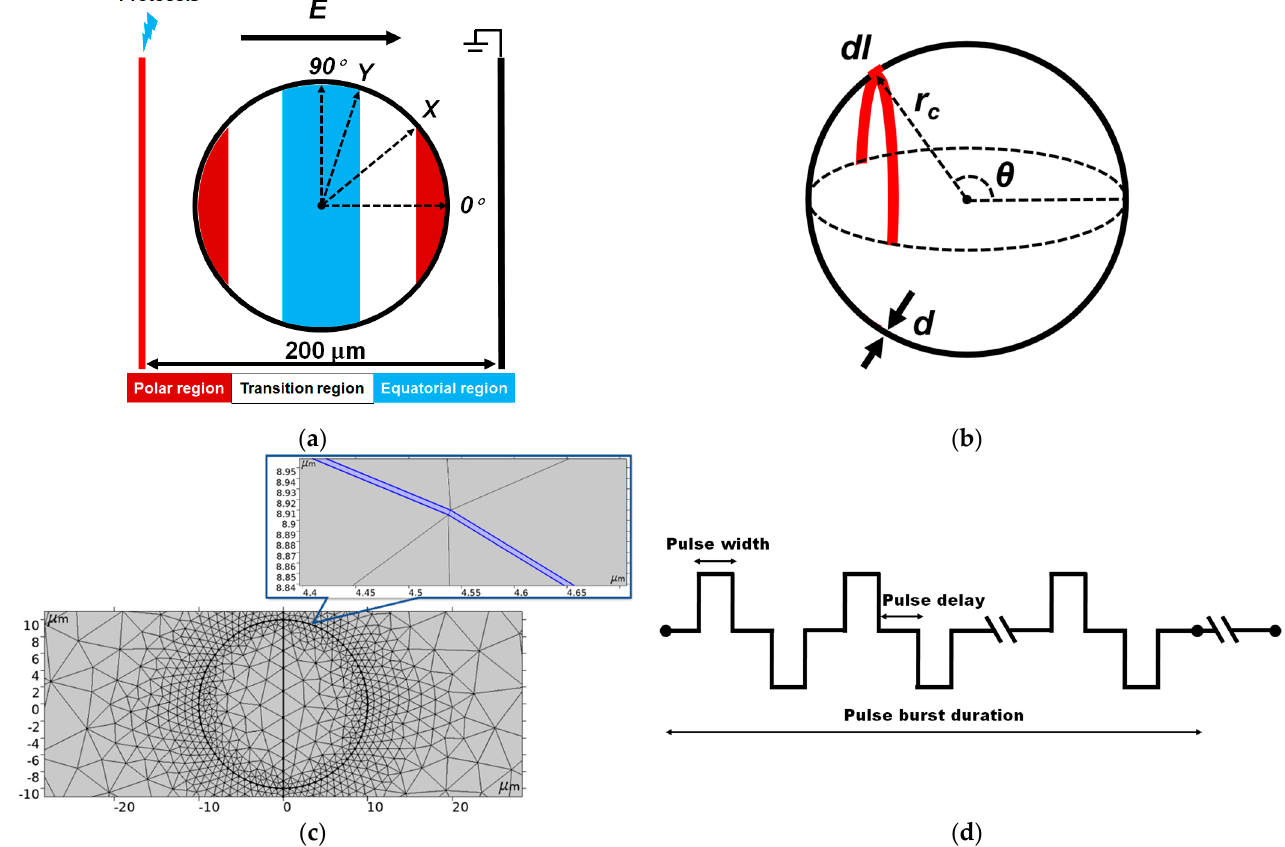
Figure 1. The schematic diagram of ( a ) the simulation space and three regions classified by different patterns of pore evolution, ( b ) the area weight of a differential of arc 𝑑𝑙 regarding the position 𝜃 , ( c ) the mesh construction of the SCE model and the close-up view of the mapped mesh of the cell membrane, ( d ) the symmetric bipolar H-FIRE protocol used in this study.